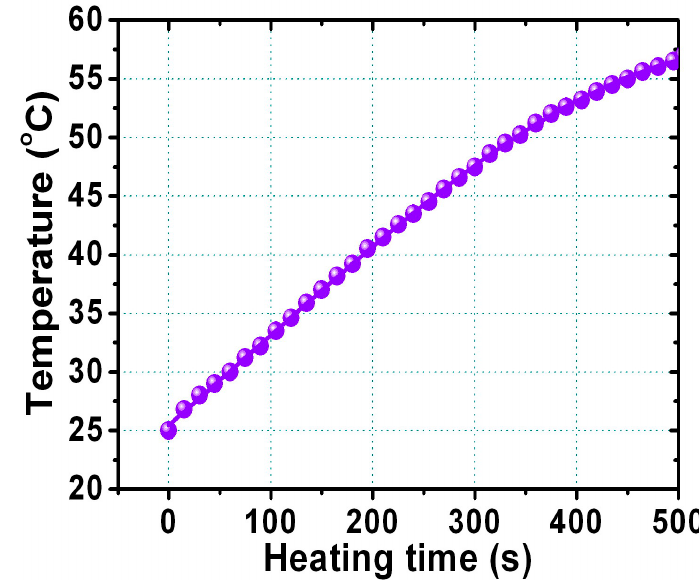
Figure 8. The relationship between rising temperature and the heating time for FePt NPs dispersed in water after ligand exchange with thiol.